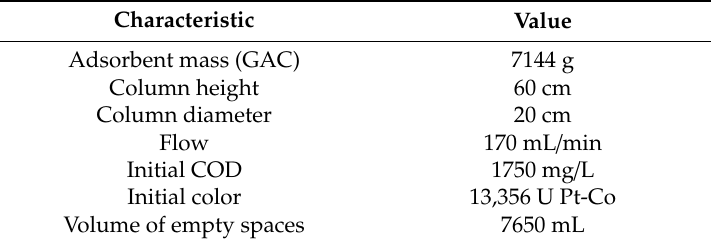
Table 8. Characteristics of the packed